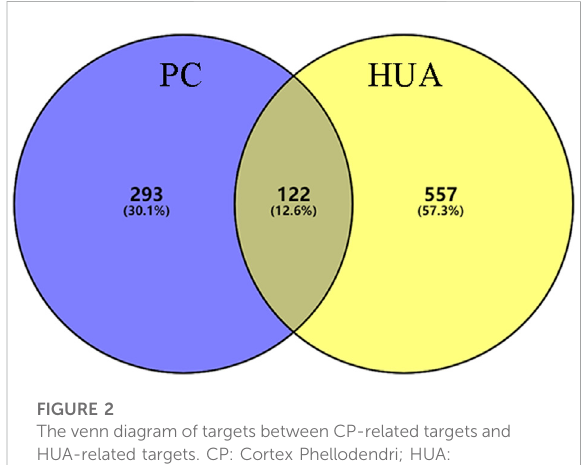
FIGURE 2 The venn diagram of targets between CP-related targets and HUA-related targets. CP: Cortex Phellodendri; HUA: